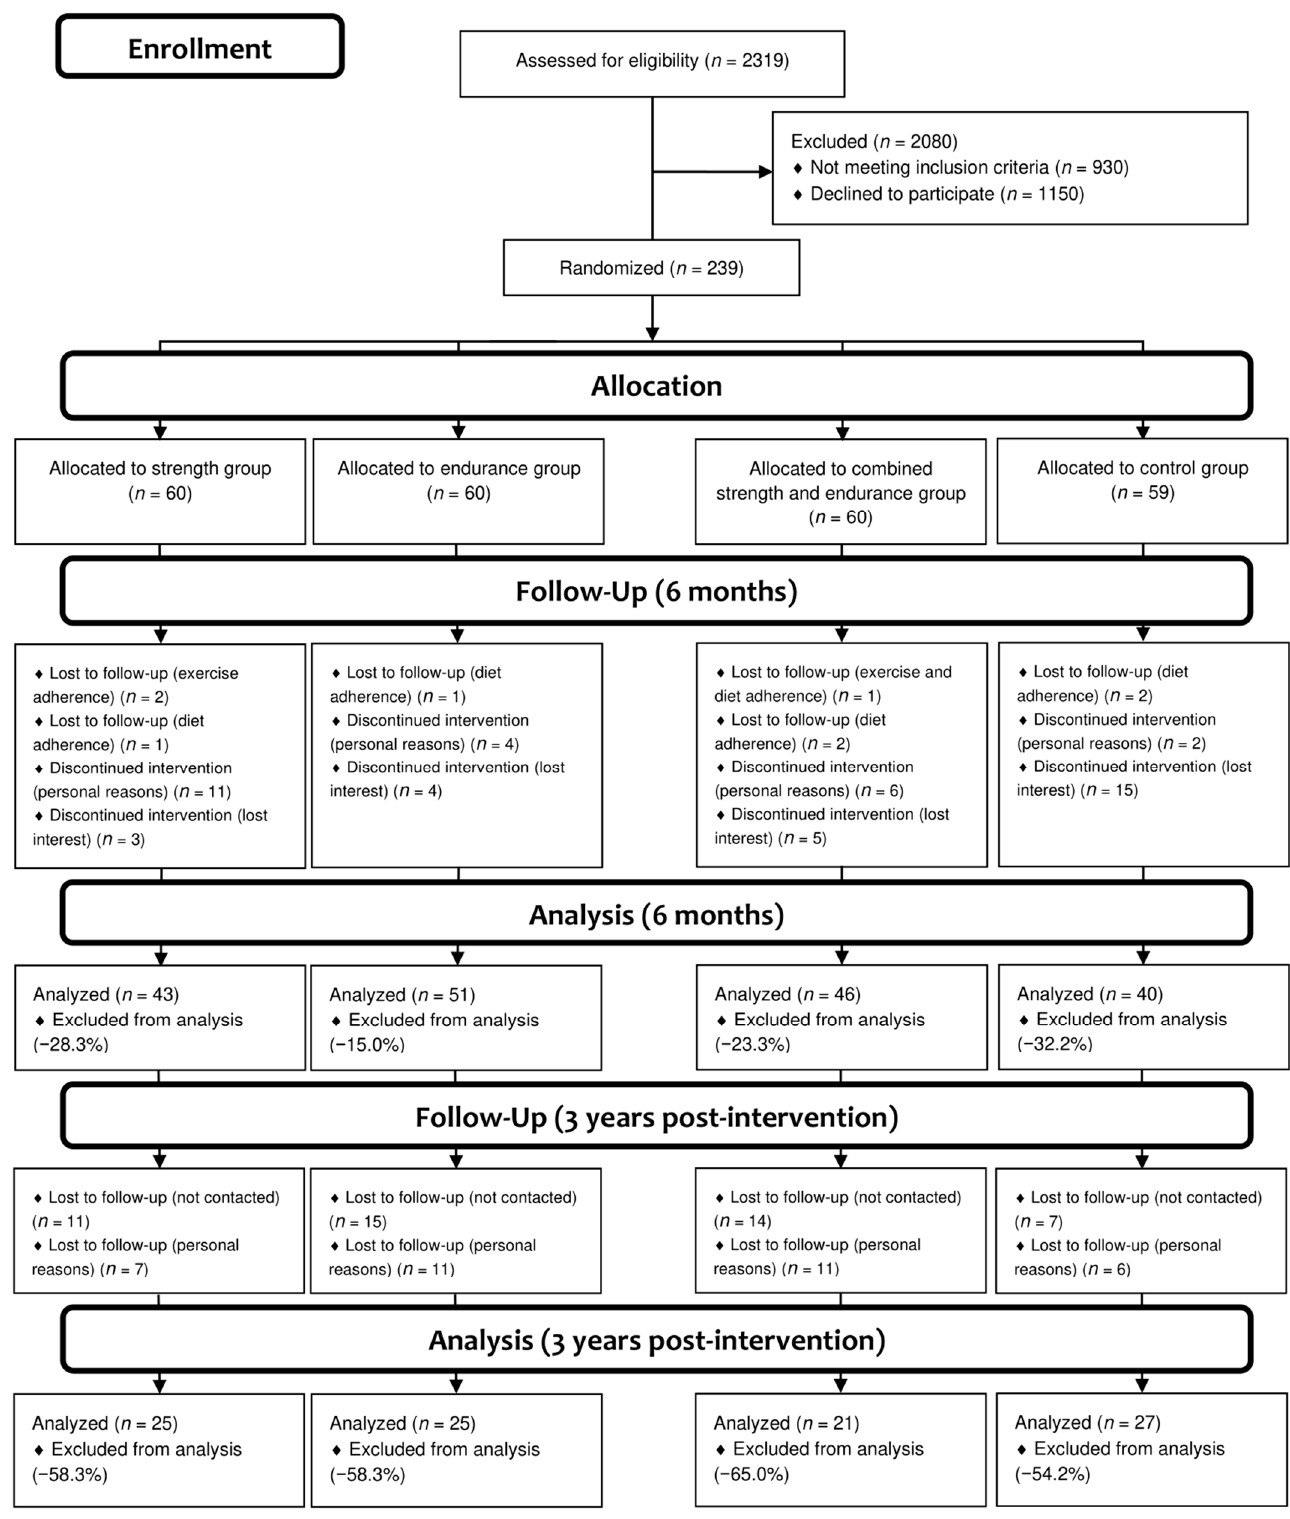
Figure 1. Participants’ flow diagram.